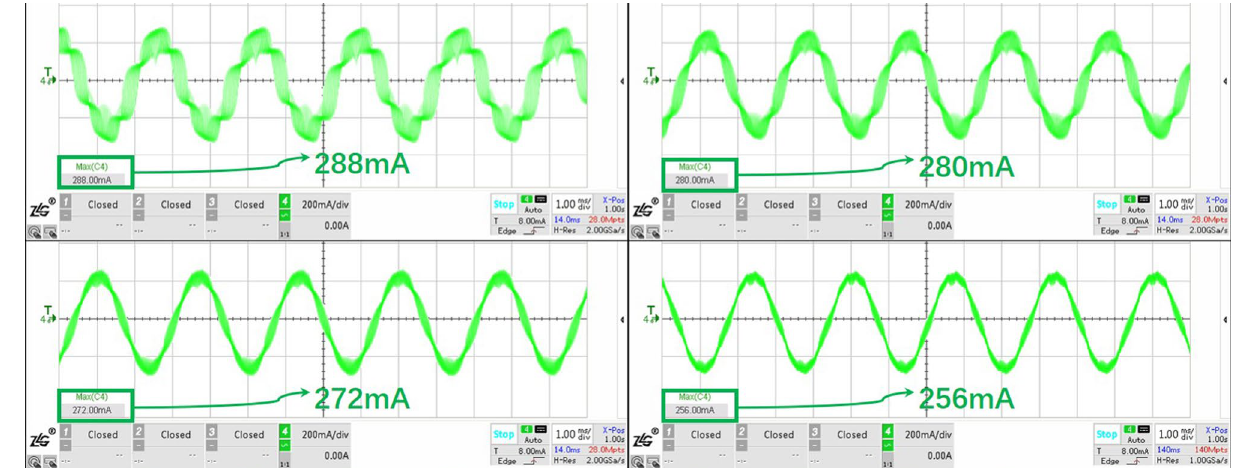
Figure 17. Experiment results of peak current: max high level counting value of TIM1 equaling V counter 1 (top- left) is 2000, top-right 1000, bottom-left 500, bottom-right 250.